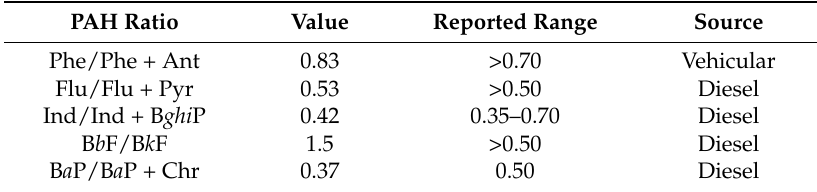
Table 5. Total sample diagnostic ratios